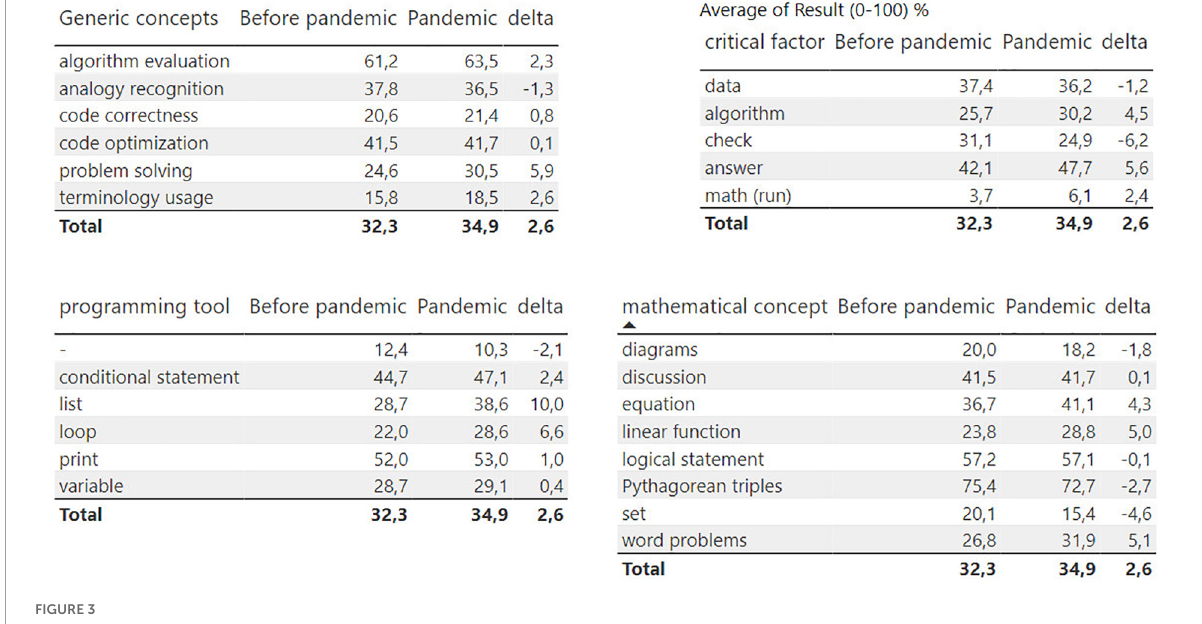
linear functions, and general word problem-solving skills proved to be significantly better. The use or recognition of other mathematical concepts was almost the same in each group.